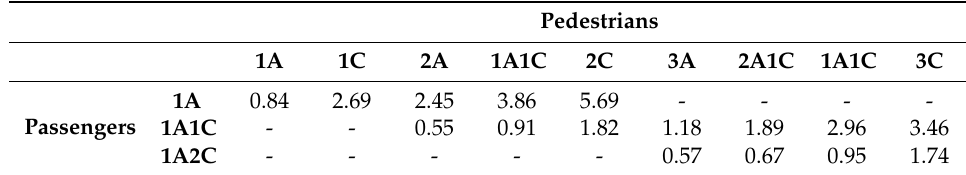
Table 3. Relative weighting of the scenarios in the pair-wise comparisons (value of pedestrian scenario as a proportion of passenger scenario).